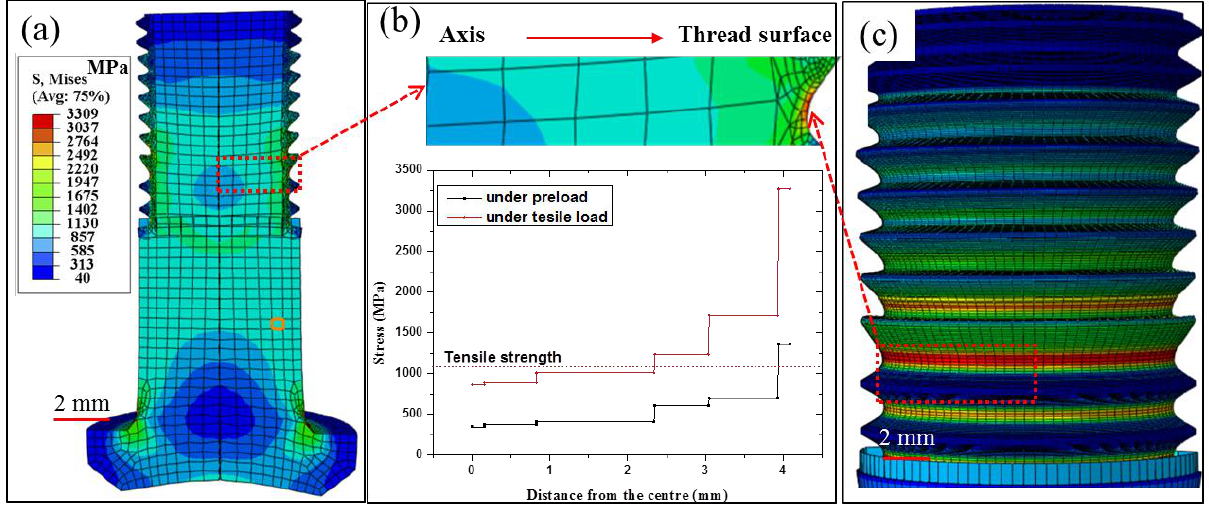
Figure 7. Von Mises stress distribution of the bolt under tensile load, ( a ), ( c ) stress nephogram of thread, ( b ) stress distribution of the thread root from cross section ( b ) stress distribution of the thread root from cross